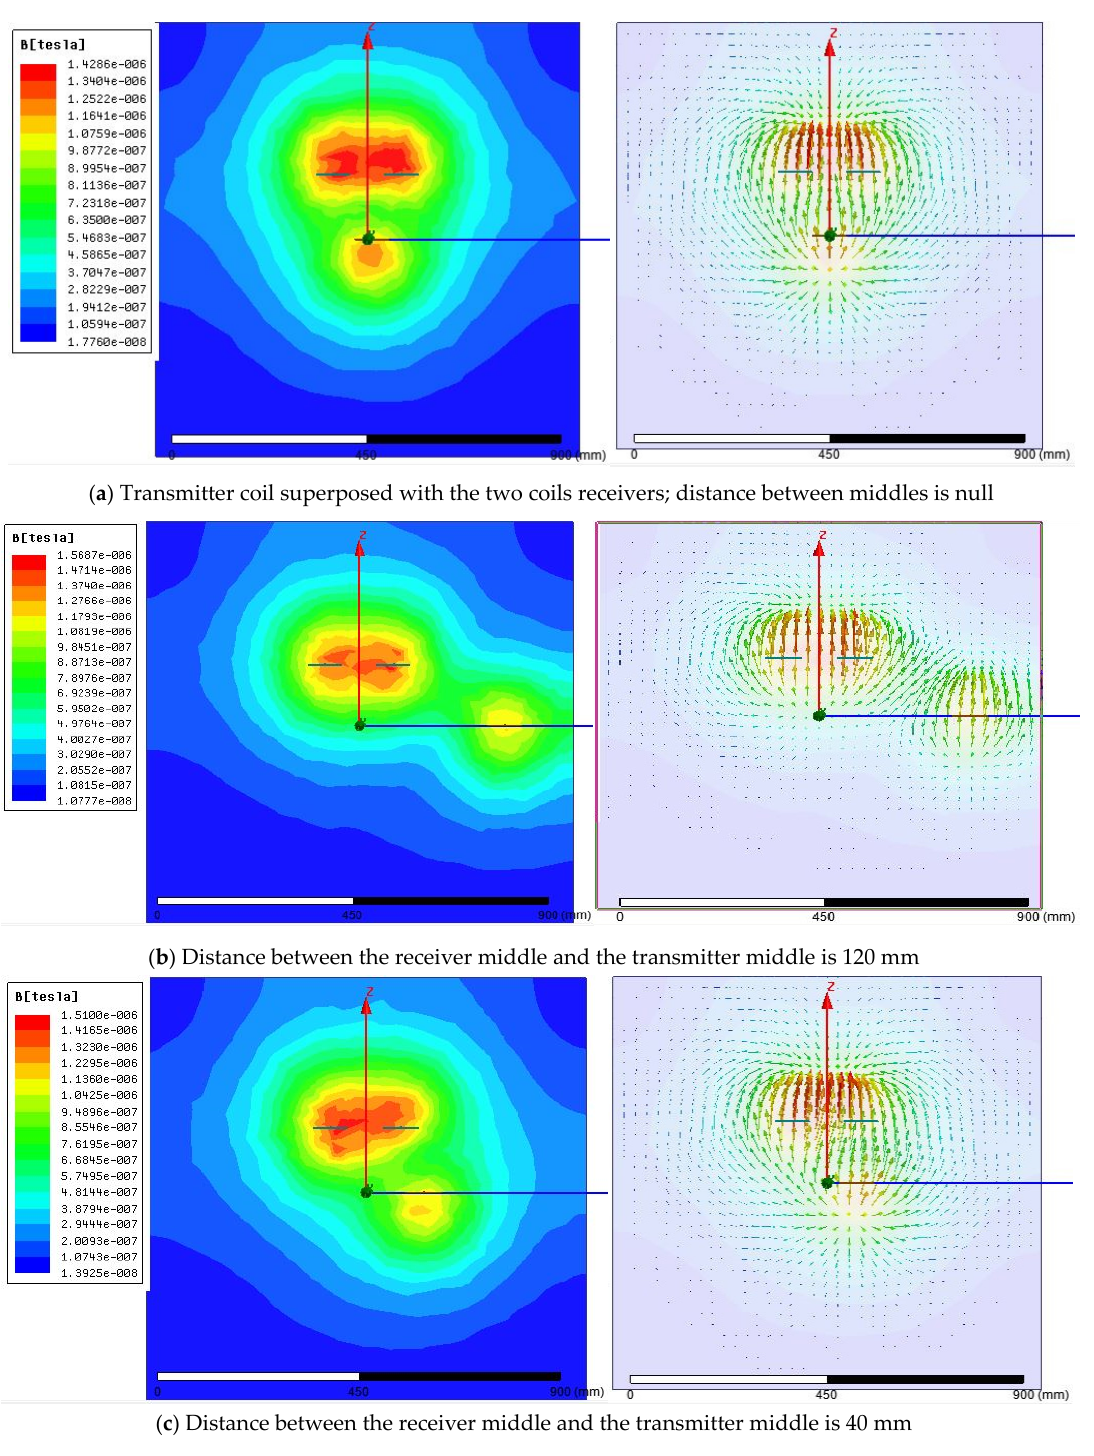
Figure 10. Distribution of magnetic flux for two coils receivers case.